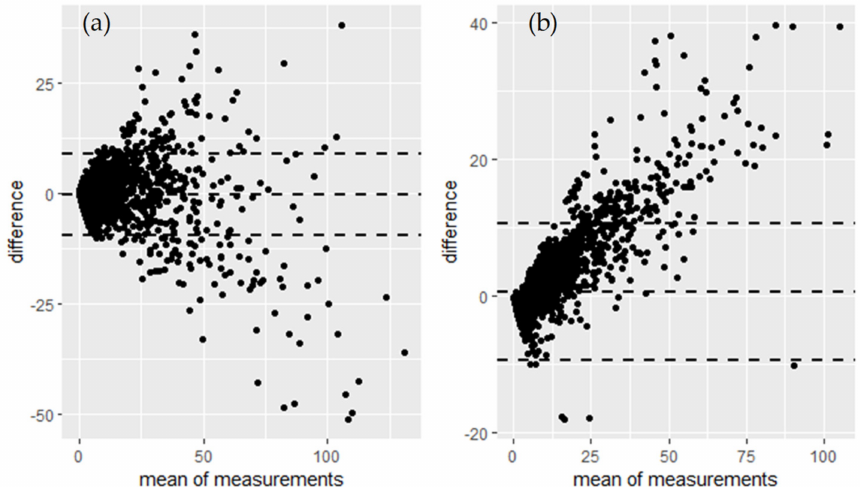
Figure 4. Bland-Altman plots of hourly PM 2.5 concentrations measured with the SMOG units com- pared to ( a ) the E-sampler and ( b ) Fidas, both corrected against the gravimetric mass